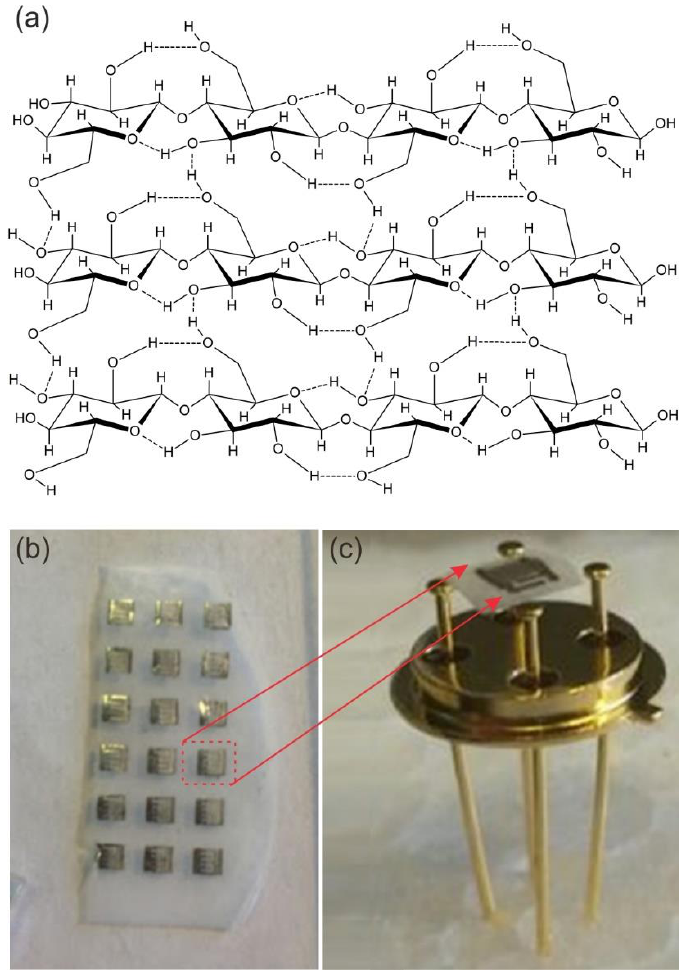
Figure 2. ( a ) Glucose polymer chains showing H bonds interaction [27], ( b ) ZnO film deposited on the bacterial cellulose (BC) with the interdigitated electrodes over the oxide material surface, ( c ) a ZnO-based sensor obtained on the BC and mounted on a case (TO39 package from Schott Electronic Packaging Asia Pte. Ltd.) by gold wires.